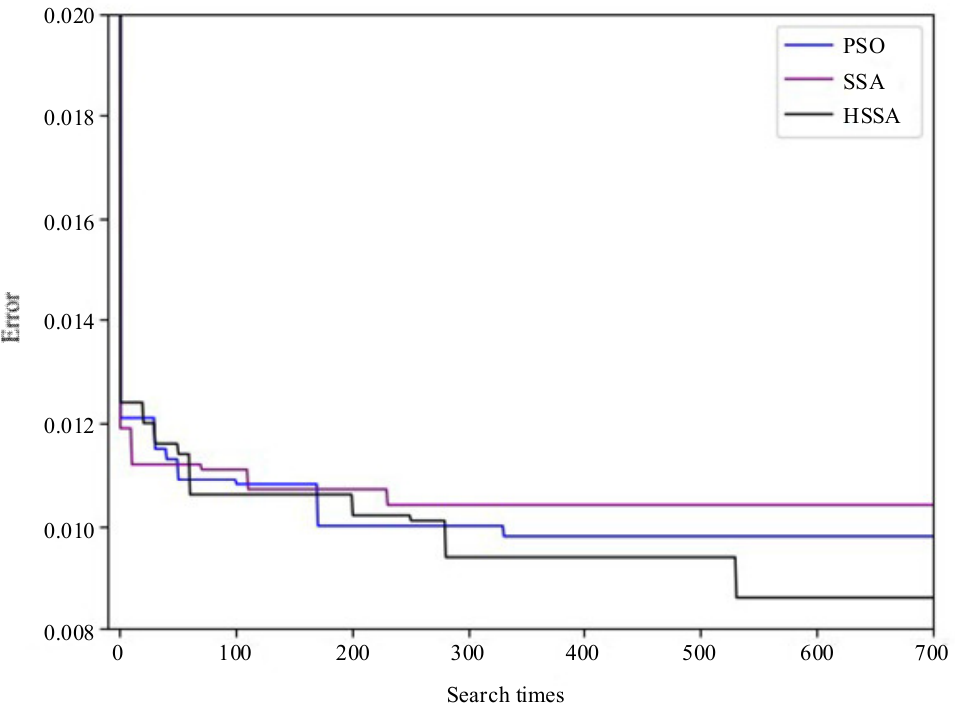
Figure 9. Results of the meaning verification experiment on Five Flowers. Figure 9 shows that effects of SSA and PSO are almost the same. HSSA is more effec- tive than the other two algorithms at 80 iterations and achieves the best effect at 470 iter- ations.